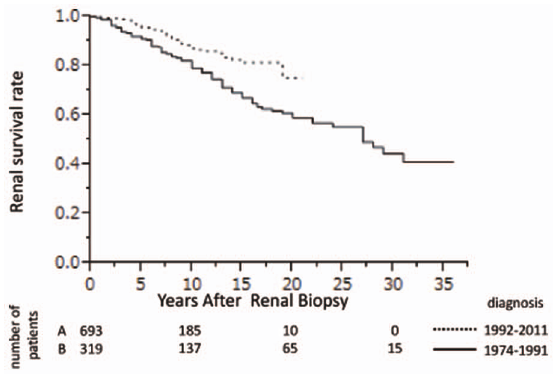
Figure 4. Renal survival rates in IgAN patients diagnosed between 1974 and 1991 and between 1992 and 2001. The 10 year (86.6% vs. 79.1%) and 20 year (75.2% vs. 59.0%) renal survival rates were significantly higher in patients diagnosed between 1992 and 2011 than in between 1974 and 1991 (P=0.0002).